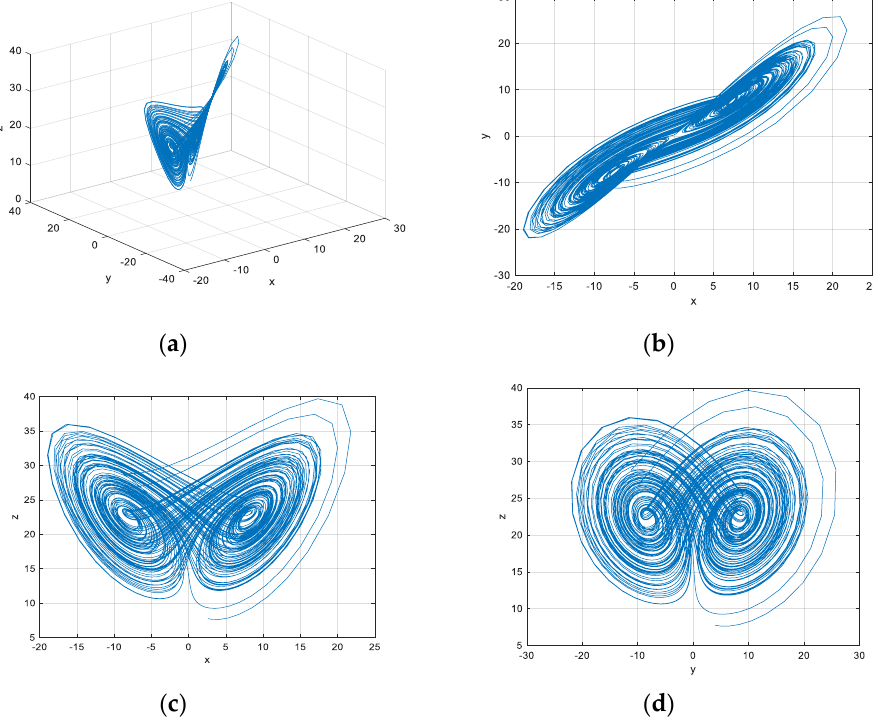
Figure 6. Phase space diagram of each plane when α = 0.8. ( a ) x-y-z plane; ( b ) x- y plane; ( c ) x-z plane; ( d ) y-z plane.